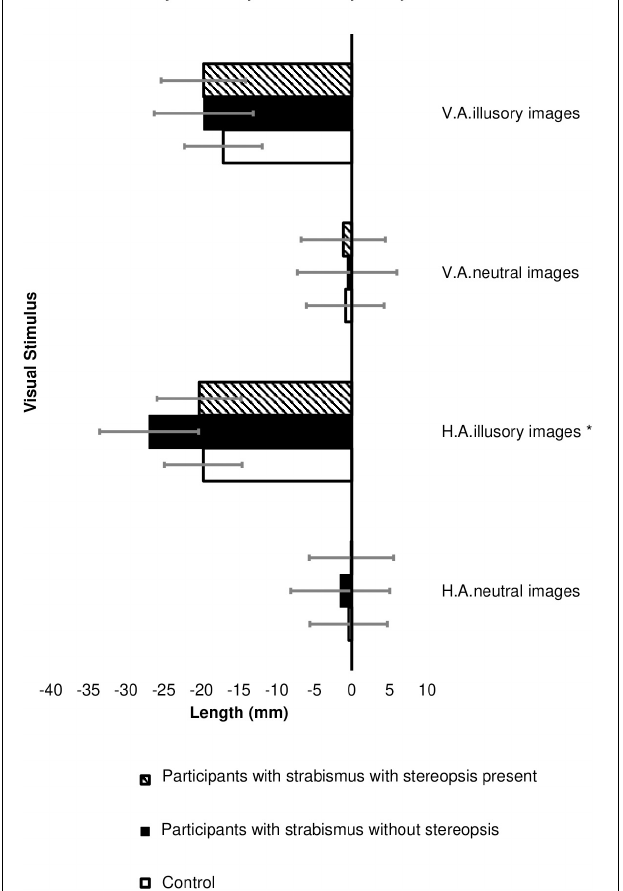
FIGURE 4 | Influence of stereopsis on image size estimation (in millimeters) in the Ponzo test between Groups: Participants with strabismus and preserved stereopsis ( n = 8), Participants with strabismus without stereopsis ( n = 37) and Controls ( n = 62). HA, horizontal adjustment images; VA, vertical adjustment images; Ponzo test: * p -value = 0.007 (Tukey Post Hoc p = 0.005) The error bars shown represent the Standard